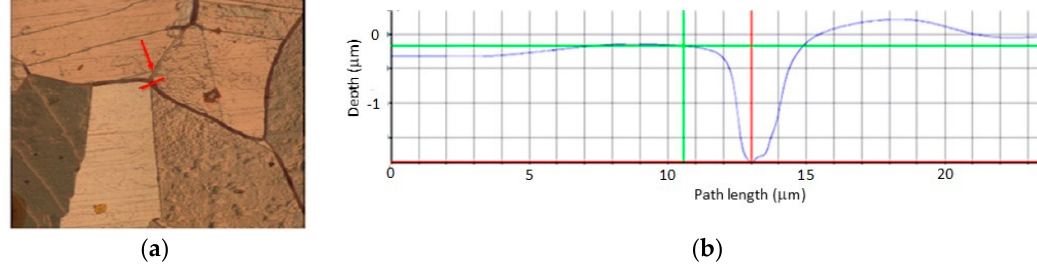
Figure 7. ( a ) FVM image of grain boundary (red line, indicated by red arrow) of sample 3. ( b ) 2D profile corresponding to the red line in ( a ).